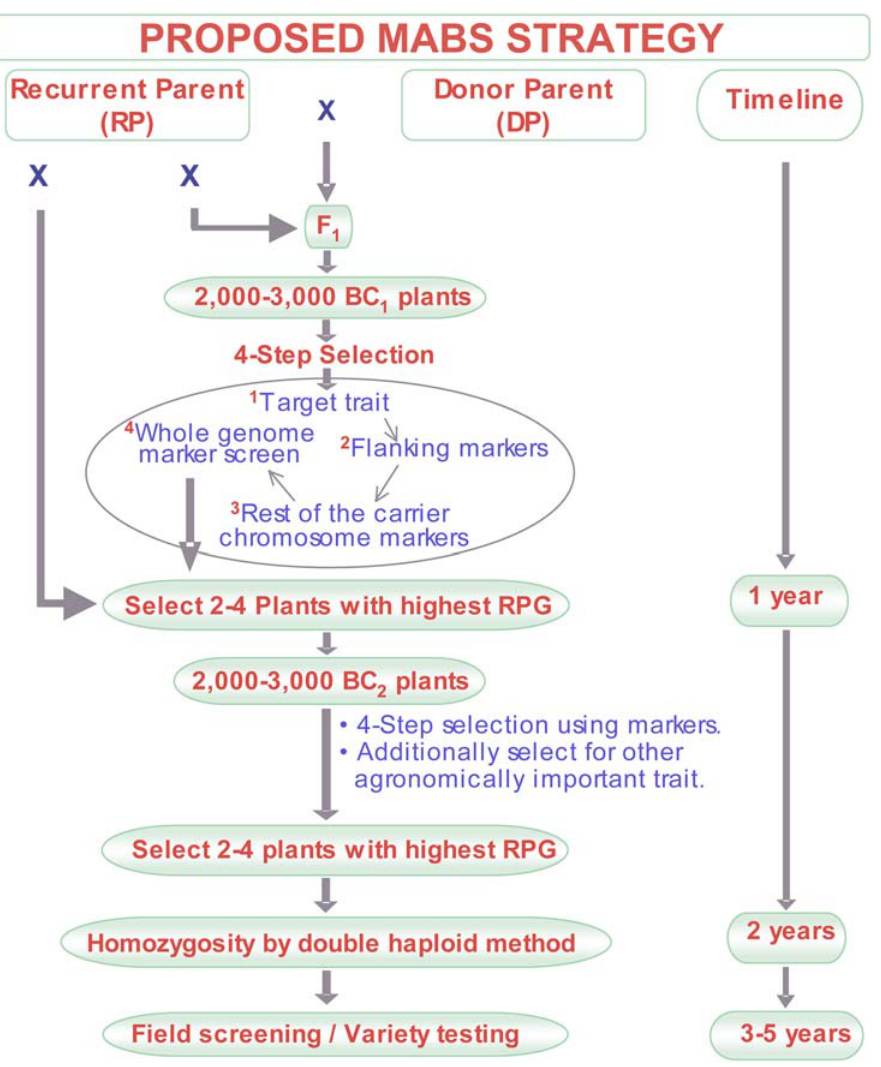
Figure 4. Proposed MABS strategy in wheat for introgressing a target gene while recovering 97% or more RPG in just two BCs.